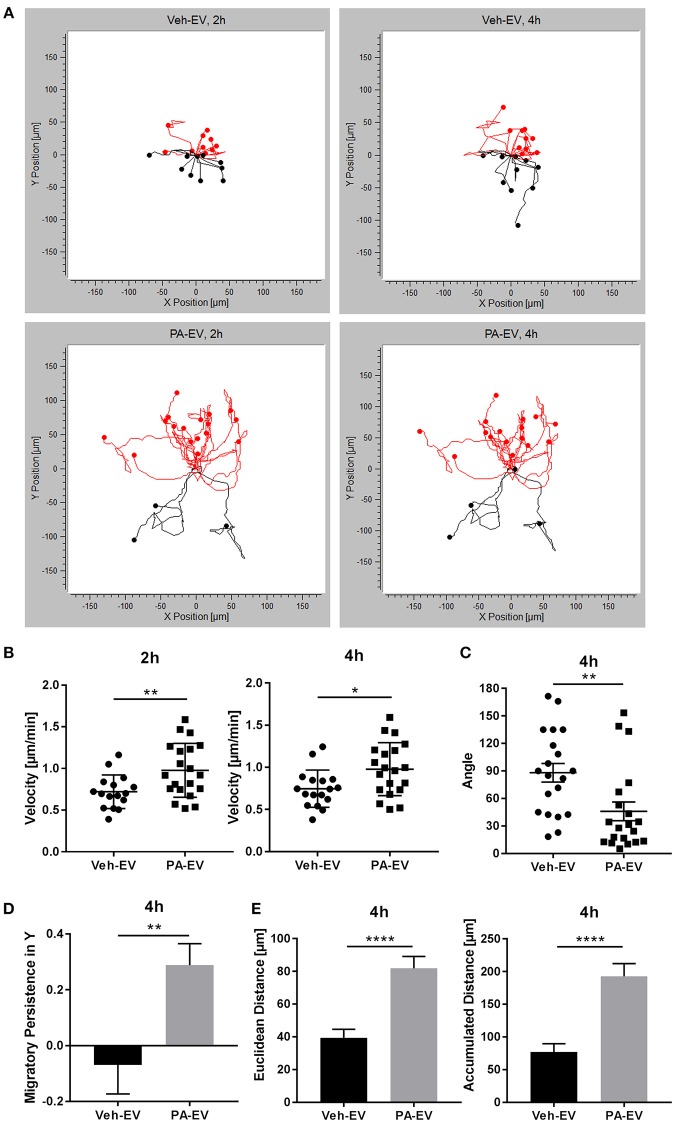
PA-EVs are chemoattractive to macrophages. (A) Representative migration plots for 2D chemotaxis assay, showing BMDM migration trajectories of 20 randomly selected cells at 2 and 4 h (n = 3). BMDMs were seeded in the microfluidic gradient generator for 1 h, exposed to a Veh-EV or PA-EV gradient for 4 h, and captured by time-lapse microscopy. EVs were isolated from the same number of IMH cells treated with 400 μM PA or vehicle for 20 h. Cells highlighted in red are migrating up toward the positive end of the gradient. The Rayleigh test for uniformity was used to test whether the cell distribution was uniform. (B) Migration velocity when BMDMs were exposed to a Veh-EV vs. PA-EV gradient at 2 and 4 h (n = 3). (C) Angle between the cell's leading edge and gradient axis at 4 h in a Veh-EV vs. PA-EV gradient (n = 3). A more acute angle indicates that migration was more consistent with the gradient axis. (D) Migratory persistence in Y of BMDMs treated with Veh-EV vs. PA-EV gradient at 4 h (n = 3). Strong chemotaxis effects are characterized by higher migratory persistence in Y. (E) Euclidean distance (shortest distance between the start and end points) and accumulated distance (total path length) between BMDMs migrating in a Veh-EV or PA-EV gradient for 4 h (n = 3). *p < 0.05, **p < 0.01, ****p < 0.0001. All error bars are SEM.